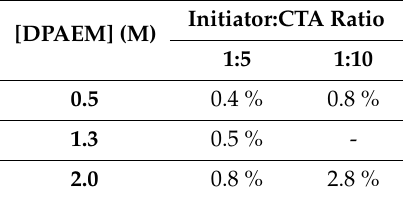
Table 2. Weight fraction of pDAEM in the MSN shell incorporated by grafting- from approach.